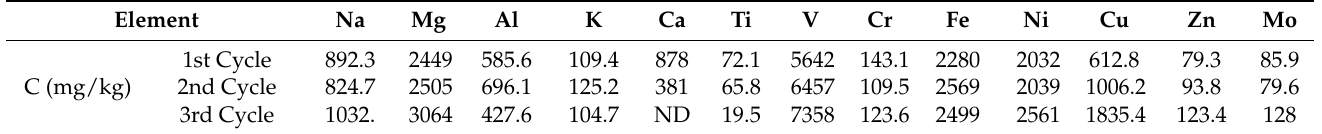
Table 4. Concentrations of minor elements present in the waste after treatment obtained by